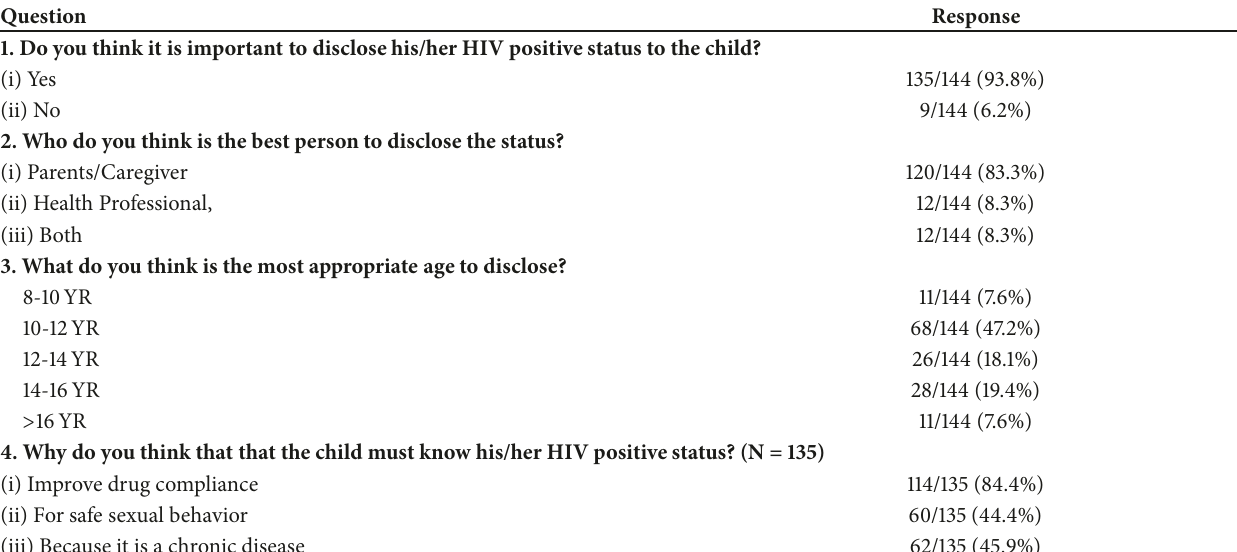
Table 3: Perceptions of caregivers regarding